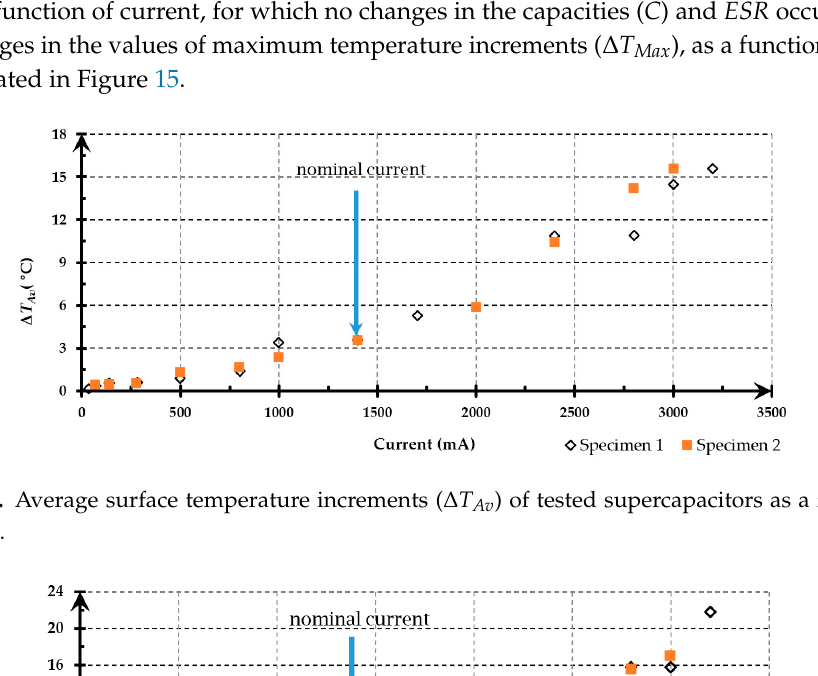
Figure 13. Distribution of supercapacitor temperature field at voltage U = 3.6 V and current I = 3200 mA.